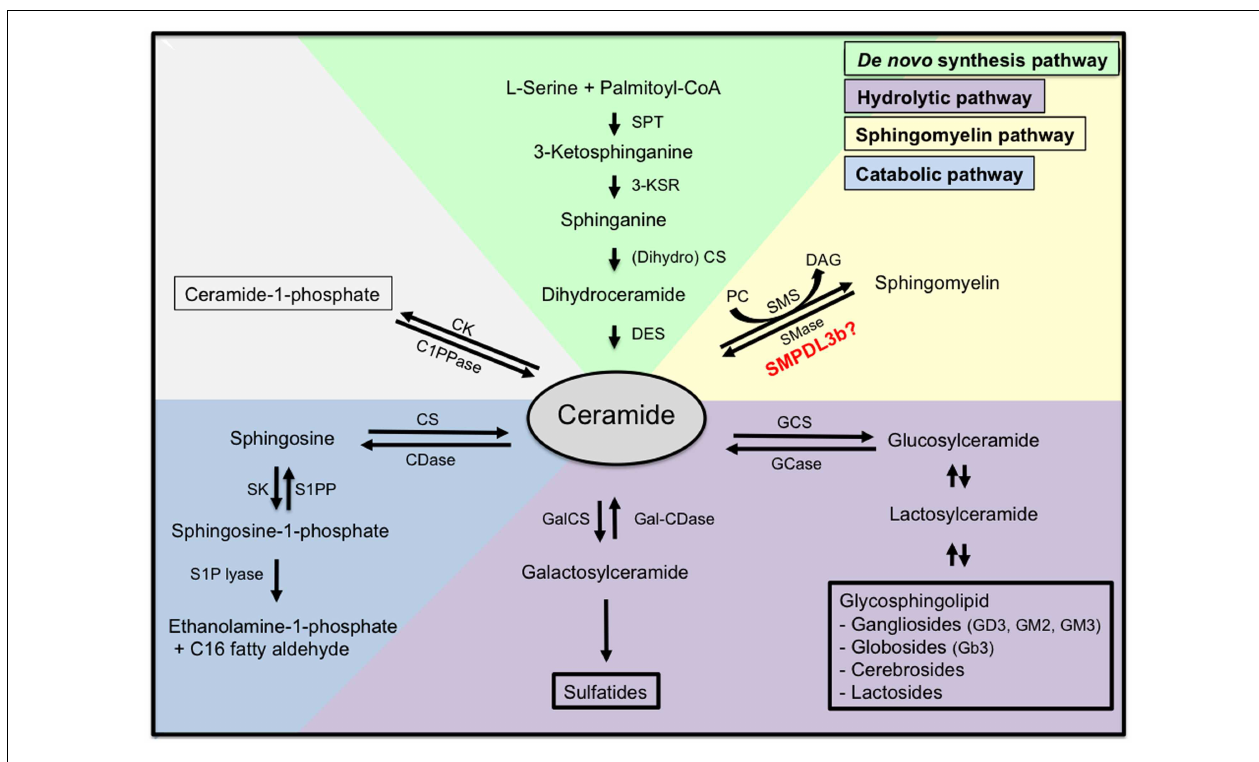
C16 fatty aldehydes. SPT, serine palmitoyl transferase; 3-KSR, 3-ketosphinganine reductase; CS, ceramide synthetase; DES, dihydroceramide desaturase; SMase, sphingomyelinase; SMS, sphingomyelin synthetase; PC, phosphatidylcholine; DAG, diacylglycerol; C1PPase, ceramide-1-phosphate phosphatase; CK, ceramide kinase; CDase, ceramidase; CS, ceramide synthase; SK, spingosine kinase; S1PP, spingosine-1-phosphate phosphatase; GCS, glycosylceramide synthase; GCase, glycosylceramidase; GalCS, galactosylceramide synthase; Gal-CDase,